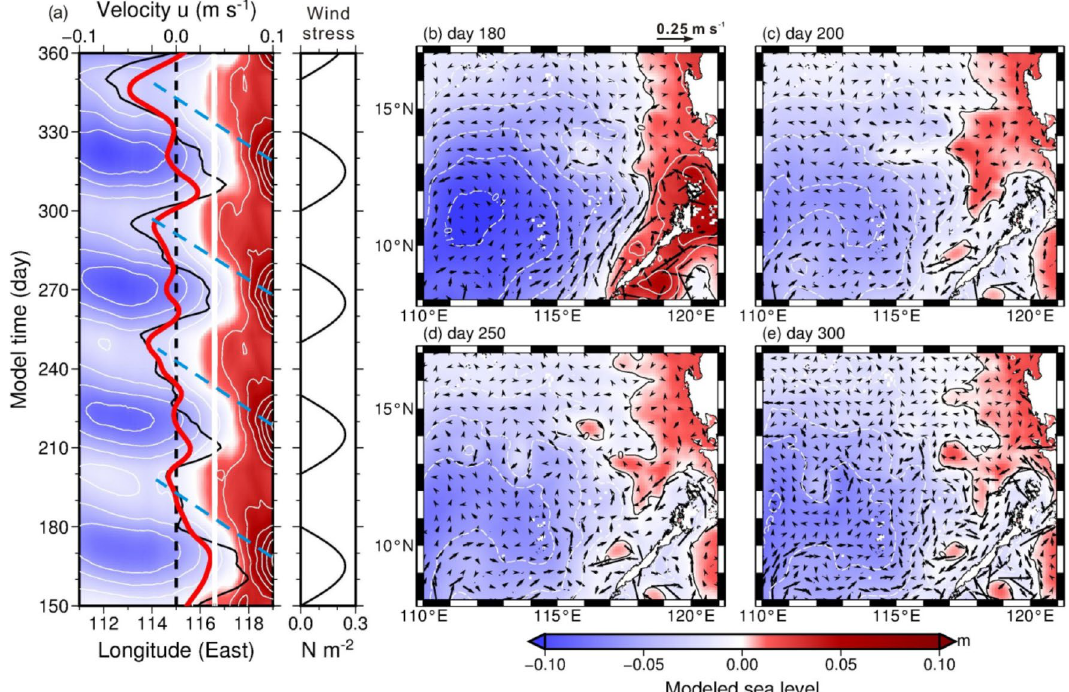
Figure 6. Model produced sea level and velocity variations from day 150 to 360. ( a ) Time versus longitude of sea level at 10.5° N and wind stress near the coast of Palawan at (118° E, 10.5° N). The 9-day low-pass-filtered 25 m depth zonal velocity (black curve) and upper 120 m depth-averaged zonal velocity (red curve) at (115° E, 10.5° N) are overlaid on the SLA plot. Blue dashed lines in ( a ) are determined by the same criterion as the yellow dashed lines in Fig. 3a, which indicate the slope of the high sea level signals. The sea level (colored) and 25 m depth velocity (arrows) at model day ( b ) 180, ( c ) 200, ( d ) 250, and ( e ) 300. The sea level contour interval is 0.02 m.